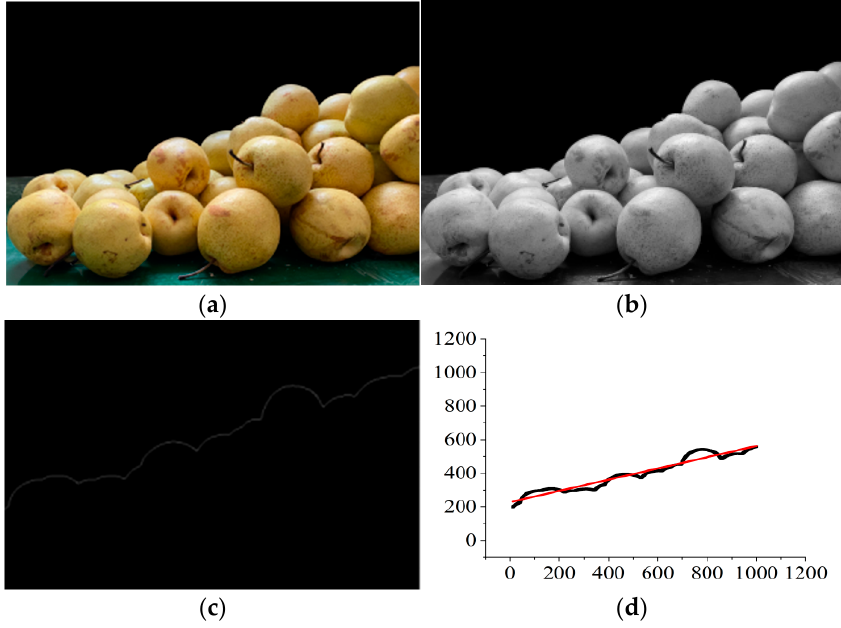
Figure 13. Processing the image of pears with Matrix Laboratory software. Original image ( a ); Grayscale processing ( b ); Boundary outline ( c ); Linear fitting ( d ). Note: The black line is the contour boundary of the pear accumulation angle, and the red line is the fitting line.